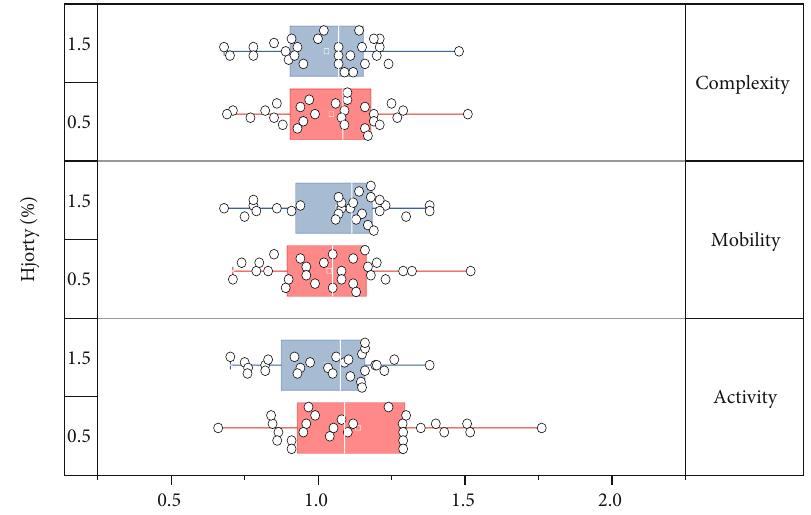
Figure 4: Statistical graph of sensitivity accuracy.